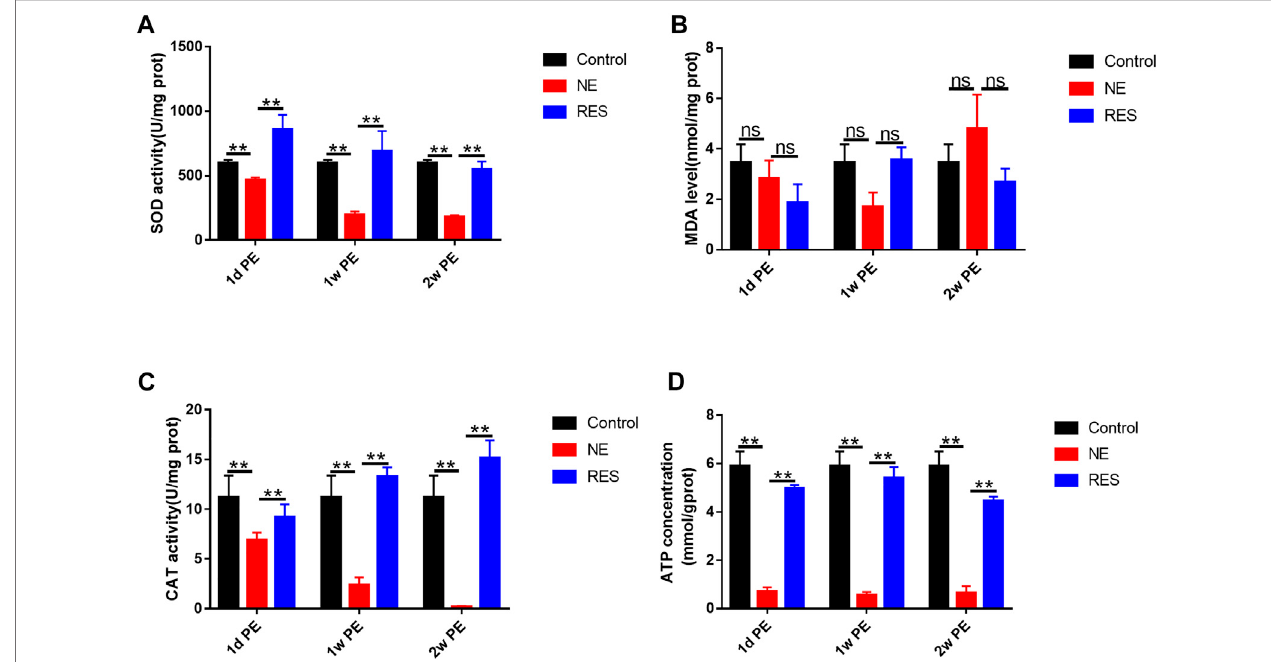
FIGURE5| SODactivity (A) ,MDA (B) ,CAT (C) andATP (D) levelsinthecochleaeofguineapigsafternoiseexposure.Thevaluesarepresentedasthemeans±SEM. Note: n = 3 from 3 animals in each group, both cochleae of the same guinea pig as a sample. * p < 0.05, ** p < 0.01.